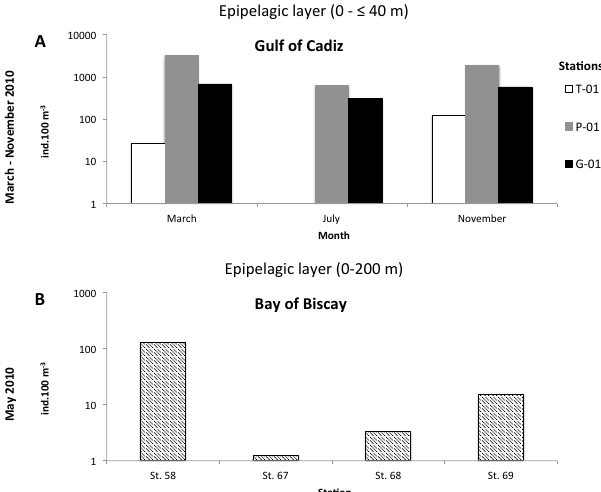
Figure 3. Total jellyfish abundance in the stations sampled in the Gulf of Cádiz (a) and in the Bay of Biscay (b)